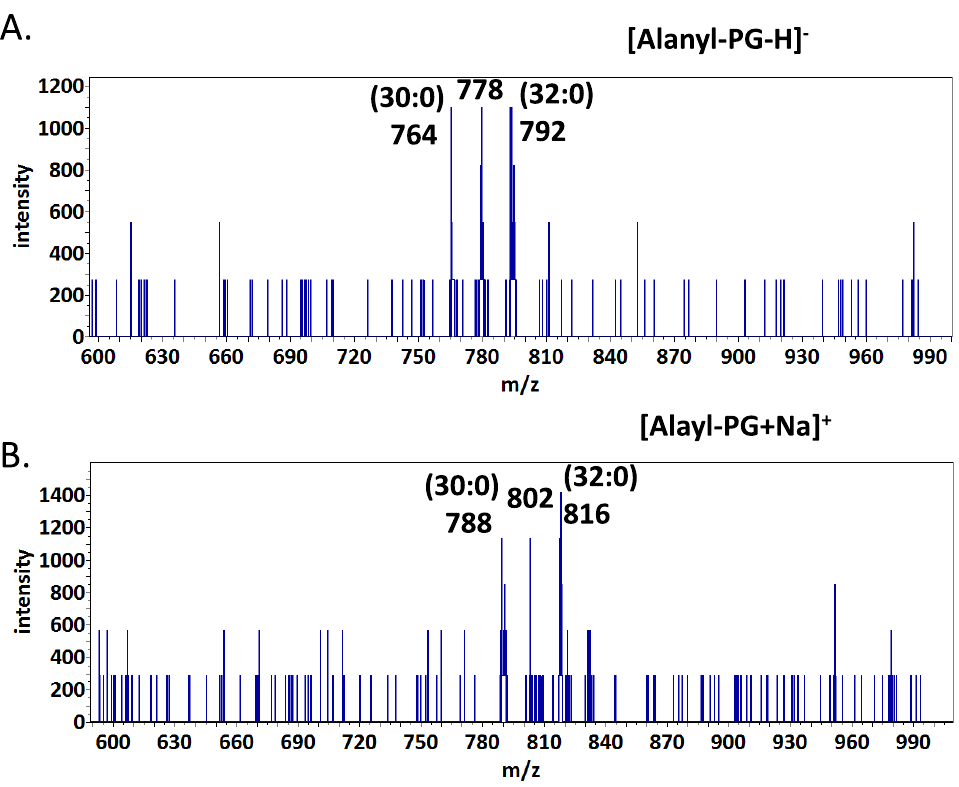
Figure 9. Precursor scans for alanyl-PGs in lipids extracted from the mprF-deficient strain. Major peaks in the spectra are labeled with fatty acid composition (number of carbon atoms: number of desaturation). A . Scan for precursors of a 88 amu anion. B . Scan for precursors of a 266 amu cation. No MCA cycles were